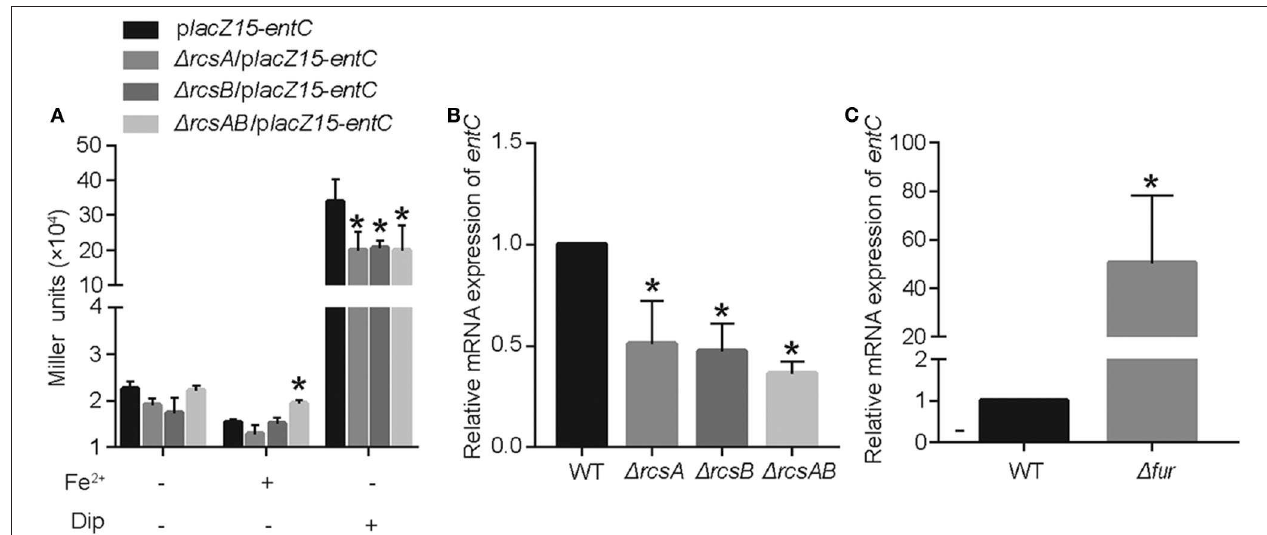
FIGURE 3 | RcsAB and Fur coregulate entC expression under different iron levels. (A) The promoter- lacZ fusion for entC was transformed into the CCW01, CCW01: ∆ rcsA , CCW01: ∆ rcsB , and CCW01: ∆ rcsAB that were then grown in LB, LB with 100 µ M FeSO 4 and LB with 250 µ M Dip. (B) When 250 µ M Dip added to LB. entC mRNA levels in WT, Kp: ∆ rcsA , Kp: ∆ rcsB , and Kp: ∆ rcsAB were measured in iron-restricted conditions via RT-qPCR analysis. One-way ANOVA was performed to determine statistically significant differences between each strain and the WT. (C) When 100 µ M FeSO 4 added to LB, WT, and Kp: ∆ fur were examined for entC expression under iron-replete conditions by RT-qPCR analysis. * P < 0.05, compared with the WT. Error bars are standard deviation.